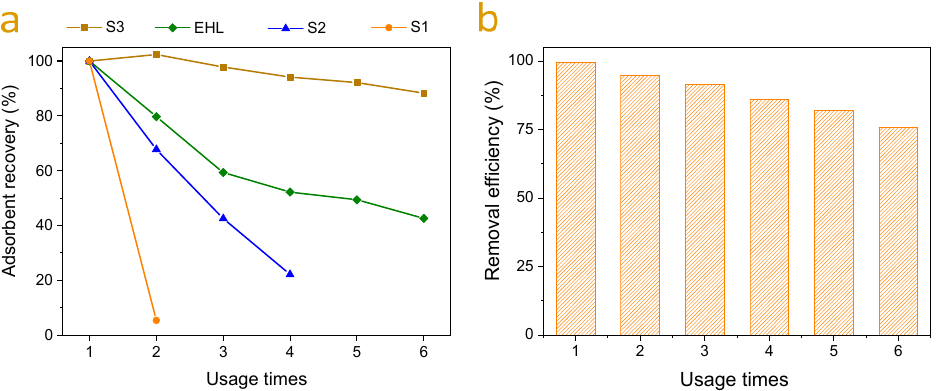
Figure 6. ( a ) Recovery of lignin adsorbents (S1, S2, S3, and EHL) under different recycle times; ( b ) adsorption capacities of S3 under different recycle times.